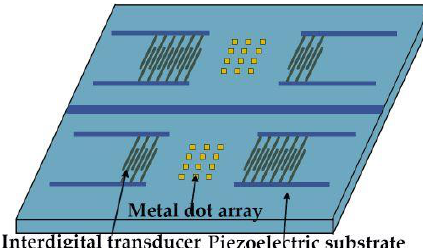
Figure 2. SAW sensor structure.